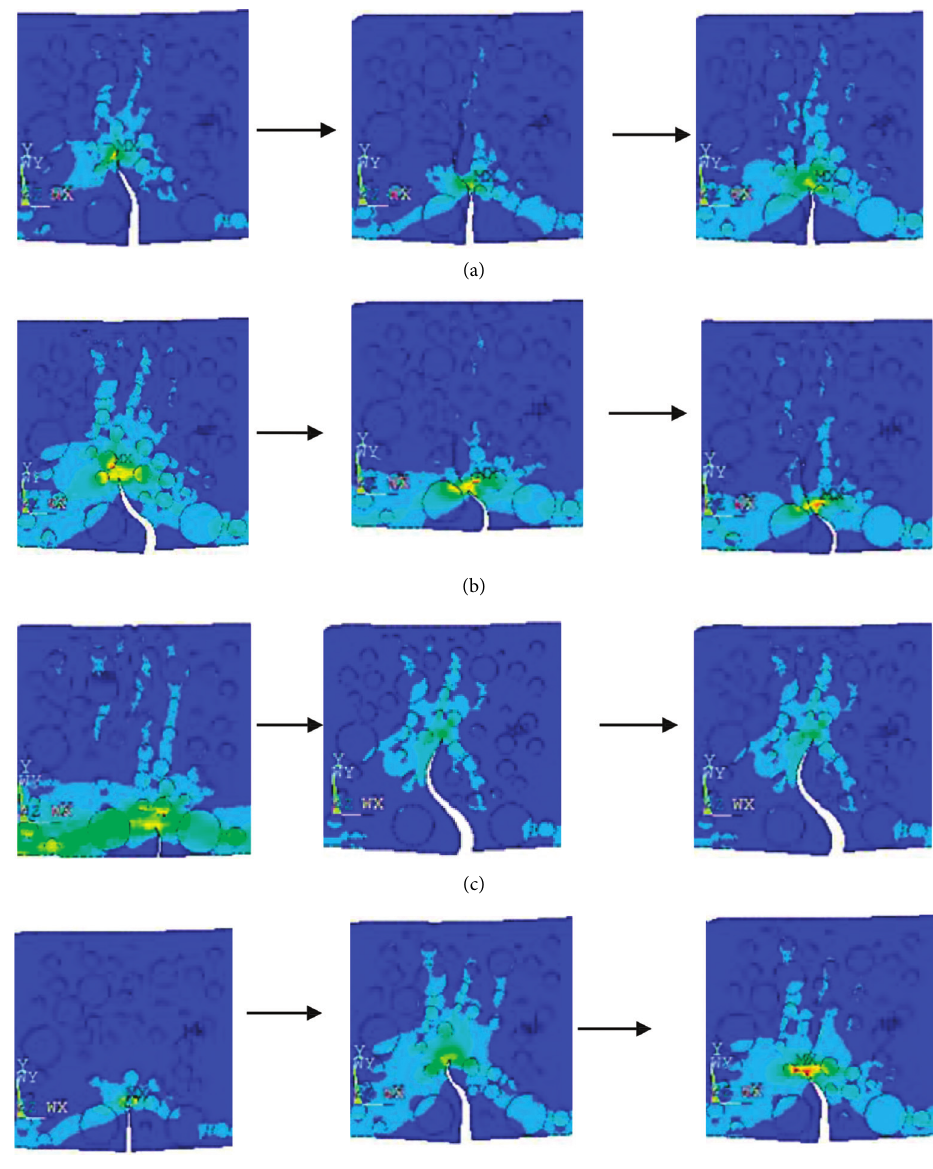
Figure 5: Concrete with large size cobbles at different gradations: (a) 20% :80%; (b) 30% :70%; (c) 40% : 60%; (d) 50%